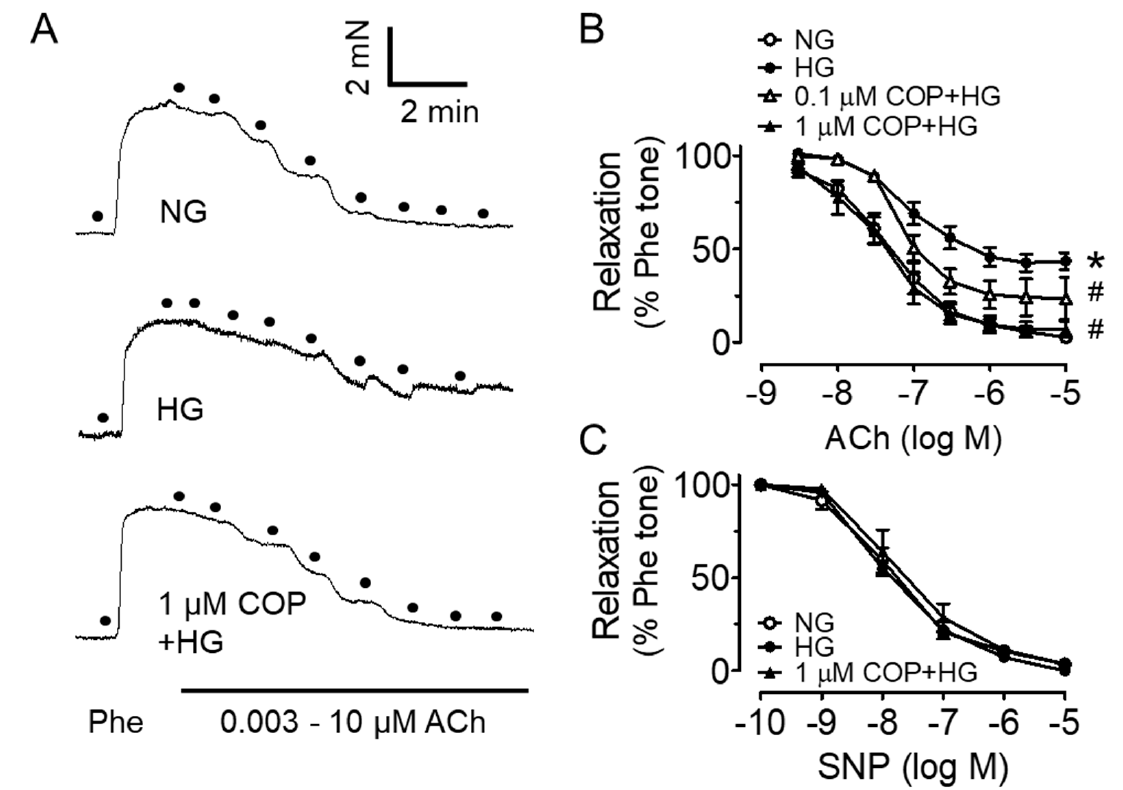
Figure 2. Vasoprotective effect of coptisine (COP) in aortas from C57BL/J mice ex vivo. ( A ) Representative traces and ( B ) summarized data showing that high glucose (HG, 30 mM, 48 h) impaired acetylcholine (ACh)-induced endothelium- dependent relaxations as compared to the control (normal glucose, NG; 5.55 mM glucose in DMEM with addition of mannitol as osmotic control), and that COP improved the relaxations. ( C ) Sodium nitroprusside (SNP)-induced endothelium- independent relaxations were not affected. Results are the mean ± SEM of 3 experiments. * p < 0.05 vs. NG; # p < 0.05 vs. HG. Table 1. p D 2 and E max (%) values for acetylcholine (ACh)-induced relaxations of mouse aortas ex- posed to high glucose (HG) and coptisine (COP) with mannitol as control (NG). Results are the